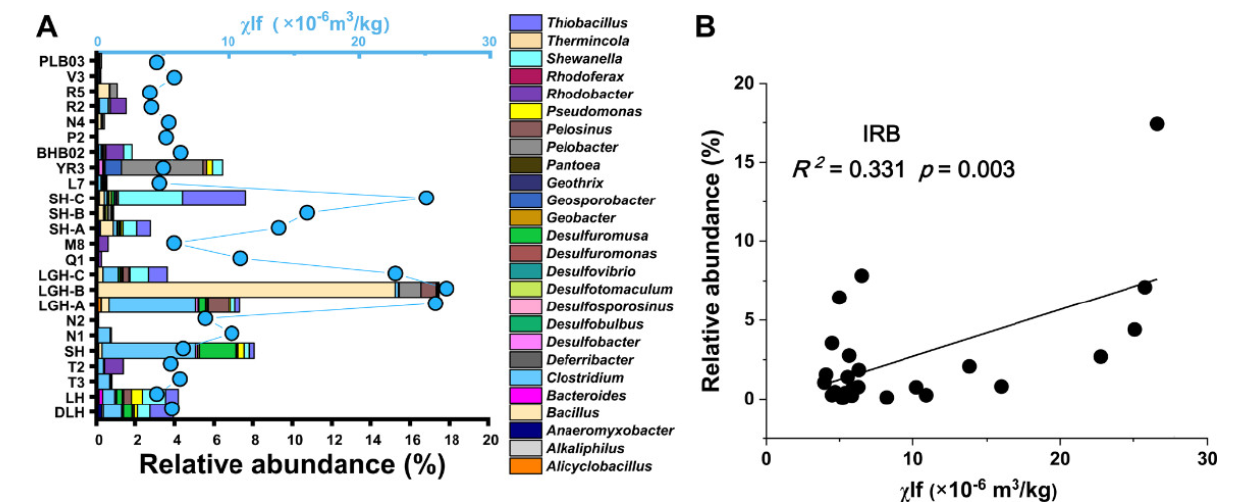
Figure 2. Relationship between iron reducing bacteria (IRB) and low-frequency susceptibility ( χ lf) values. ( A ) Relationship between genera of IRB and χ lf values of sedimental samples. Sediment χ lf values are reported in Table S1. ( B ) Regression analysis between the relative abundance of identified IRB genera and χ lf.